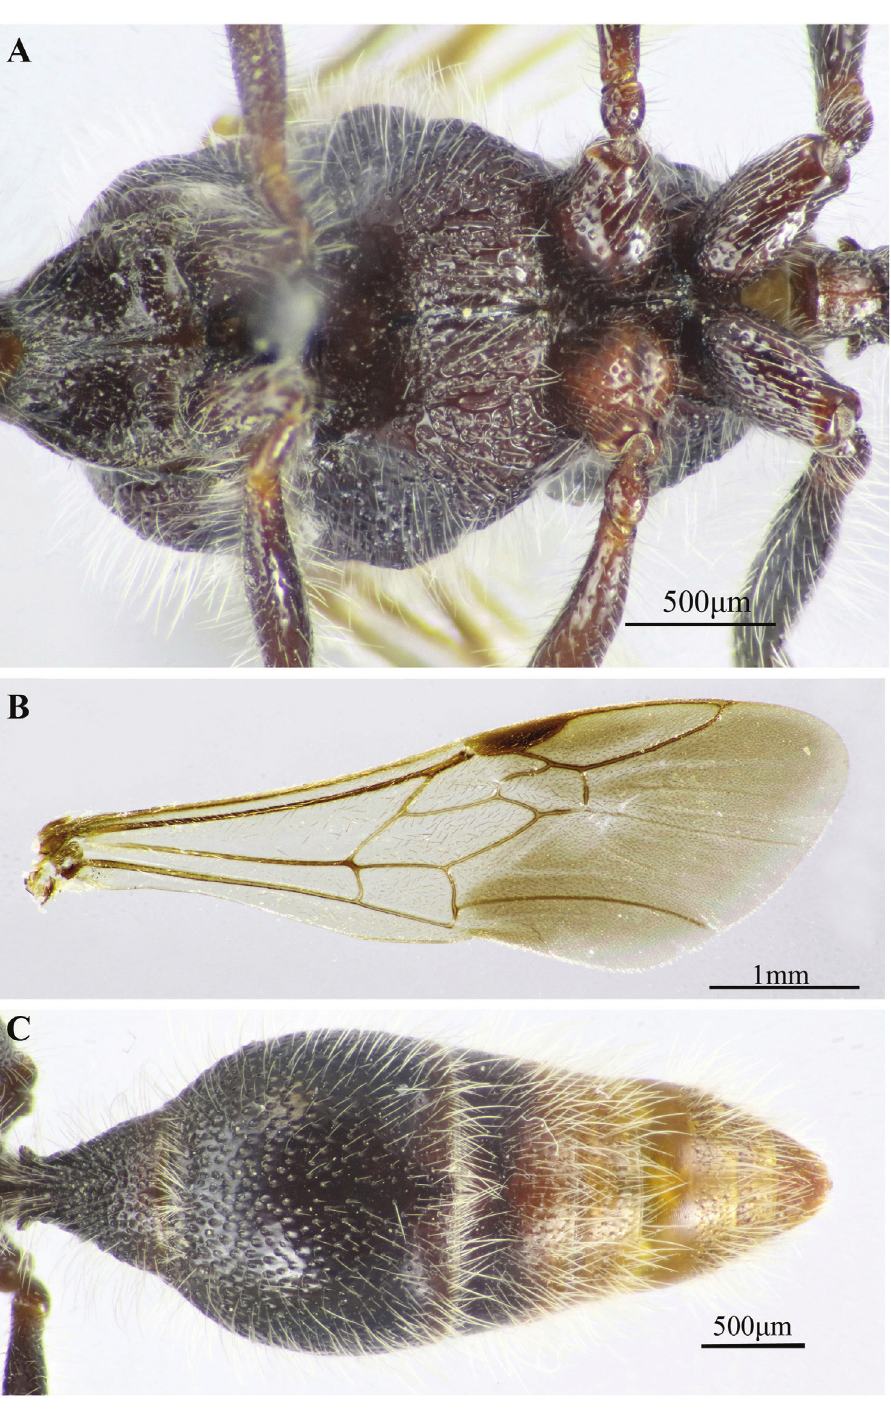
Figure 31. Pseudophotopsis subaurea sp. nov. (Male) A mesosoma, ventral view B right fore wing C meta- soma, dorsal